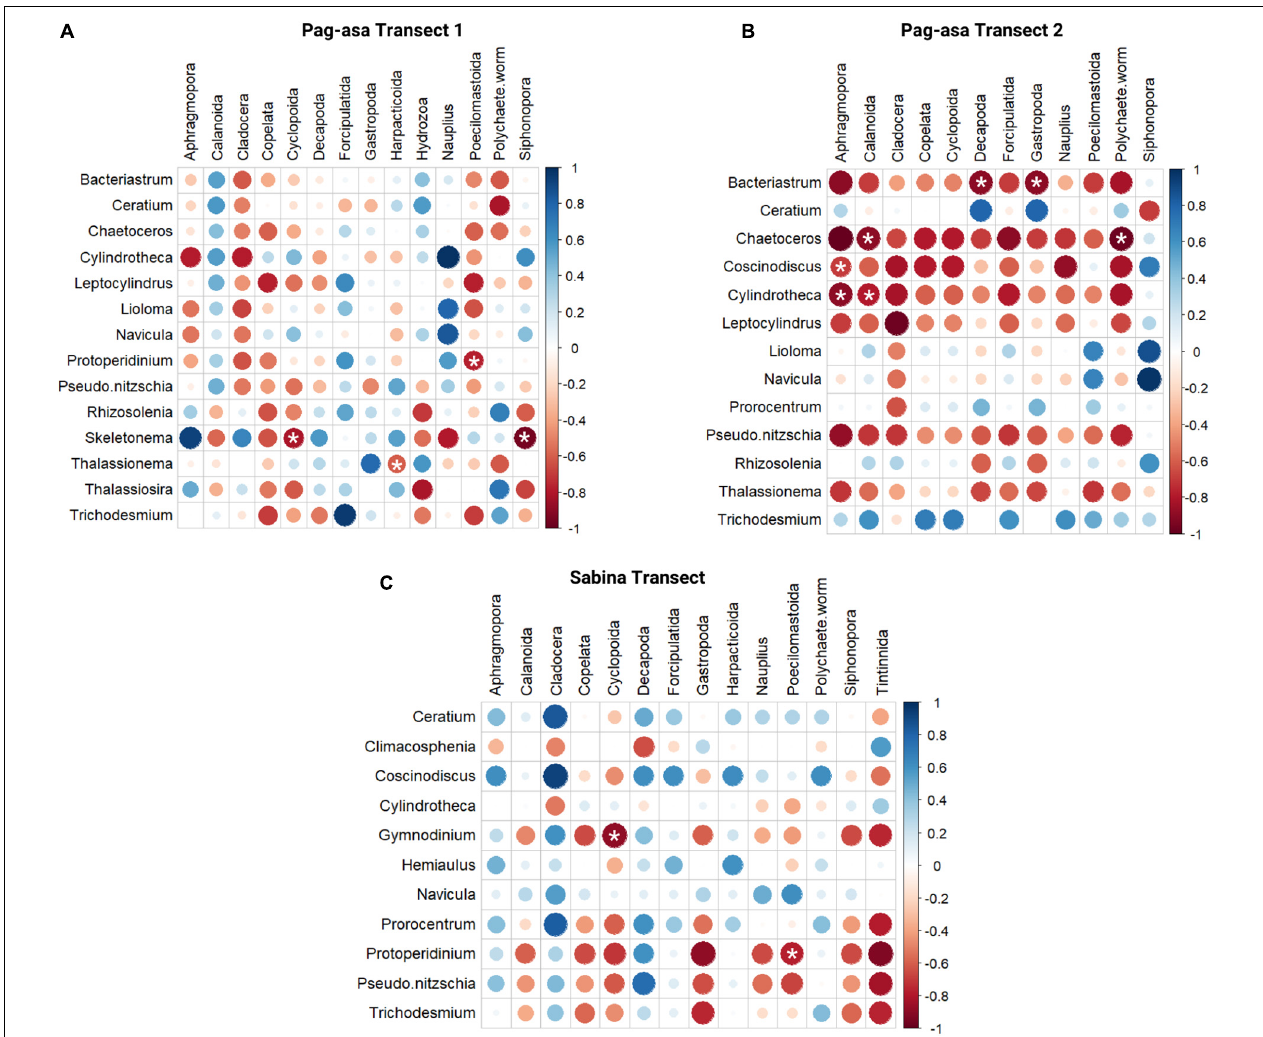
FIGURE 7 | Spearman’s correlation between phytoplankton and zooplankton taxa per transect: (A) Pag-asa Transect 1, (B) Pag-asa Transect 2, and (C) Sabina Transect. Circles with a white asterisk are the only ones that are significant at p <